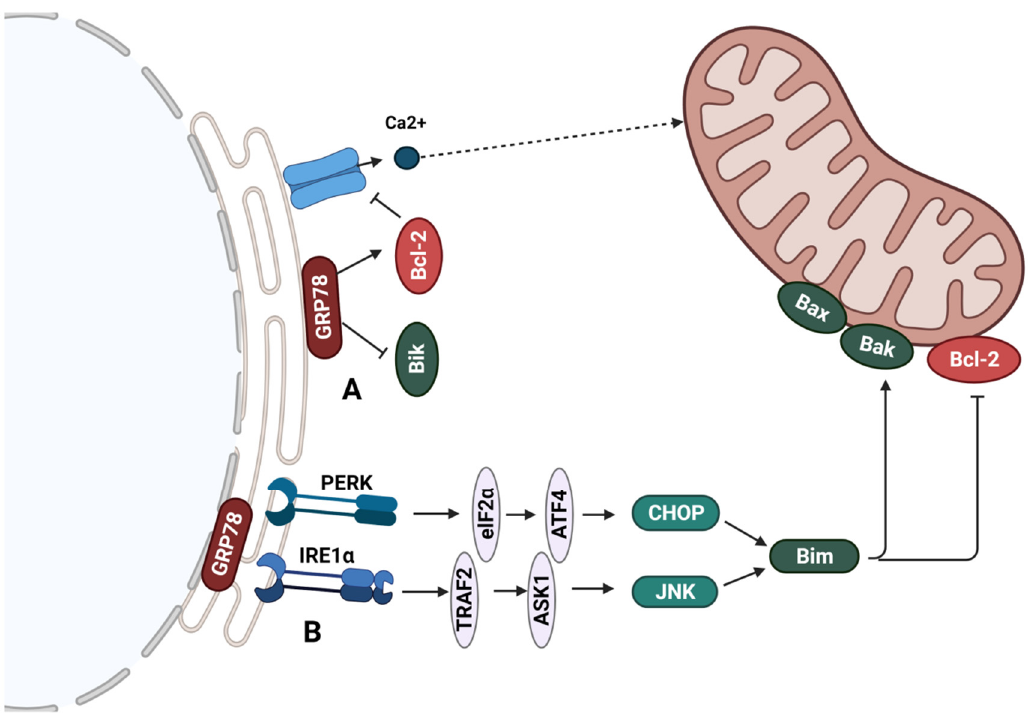
Figure 5. Regulation of apoptosis induction by Bcl-2 family proteins at the endoplasmic reticulum in endocrine-resistant breast cancer cells. ( A ) In the presence of high GRP78/BiP levels, Bik is sequestered by GRP78. Downregulation of GRP78 releases Bik, which binds Bcl-2 and blocks its antiapoptotic activity, enabling the release of Ca2+ from the ER and apoptosis induction at the mitochondria ( B ). In the presence of low levels of GRP78, induction of the UPR and activation of IRE1 α and PERK leads to cell death. IRE1 α activates JNK via the activation of TRAF2 and ASK1. JNK in- duces apoptosis through the upregulation of Bim, which can further activate Bax/Bak. PERK phos- phorylates and inactivates elF2 α resulting in the induction of ATF4 and CHOP, which has multiple downstream targets such as Bim. Created with BioRender.com (accessed on 5 December 2021).